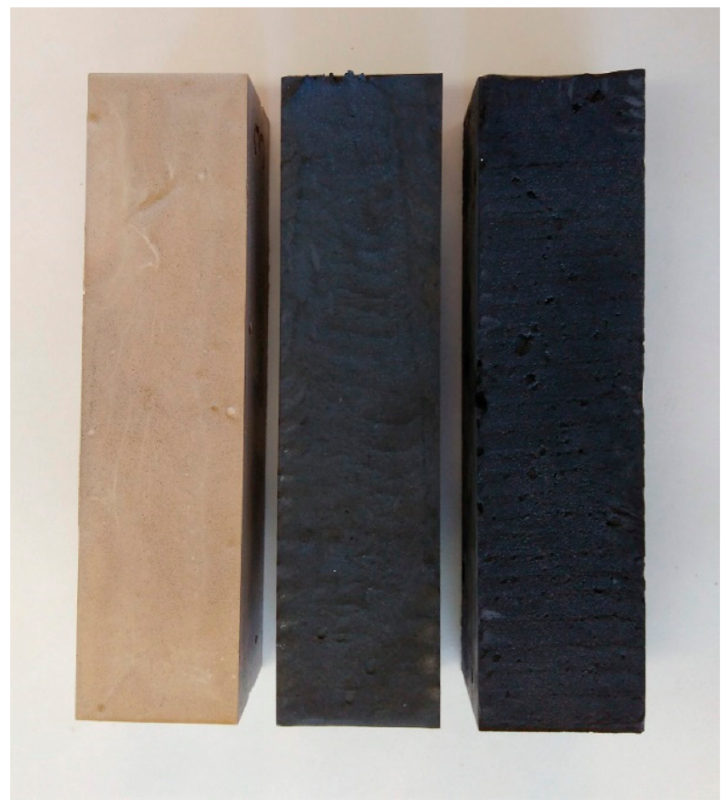
Figure 2. Photograph of the prepared composites MOC-CNT-R ( left ), MOC-CNT-0.5 ( middle ), and MOC-CNT-1 ( right